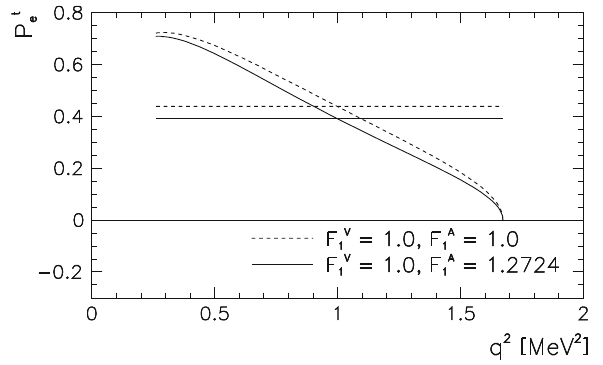
Fig. 5 Transverse polarisation of the electron as a function of q 2 for two different sets of form factors (solid and dashed lines). The straight lines represent the longitudinal polarisation integrated over q 2 ∈ [ m 2 (cid:3) ,( M n − M p ) 2